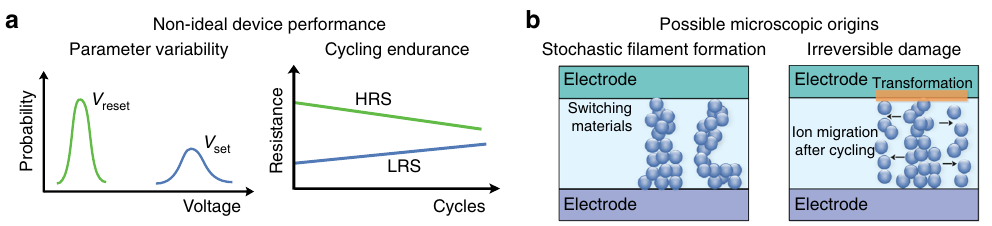
Table 1 The research status on switching mechanism of memristive devices Properties